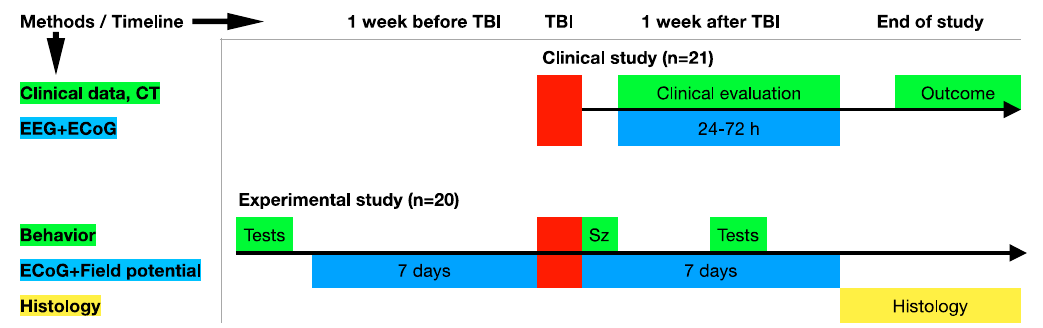
Figure 1. Study design flowchart. The study includes clinical and experimental parts. Direct translational links between them are provided through clinical and behavioral data concerning the severity of trauma and electrical activity recorded from the surface of the cerebral cortex (electrocorticograms (ECoGs)). Sz, immediate